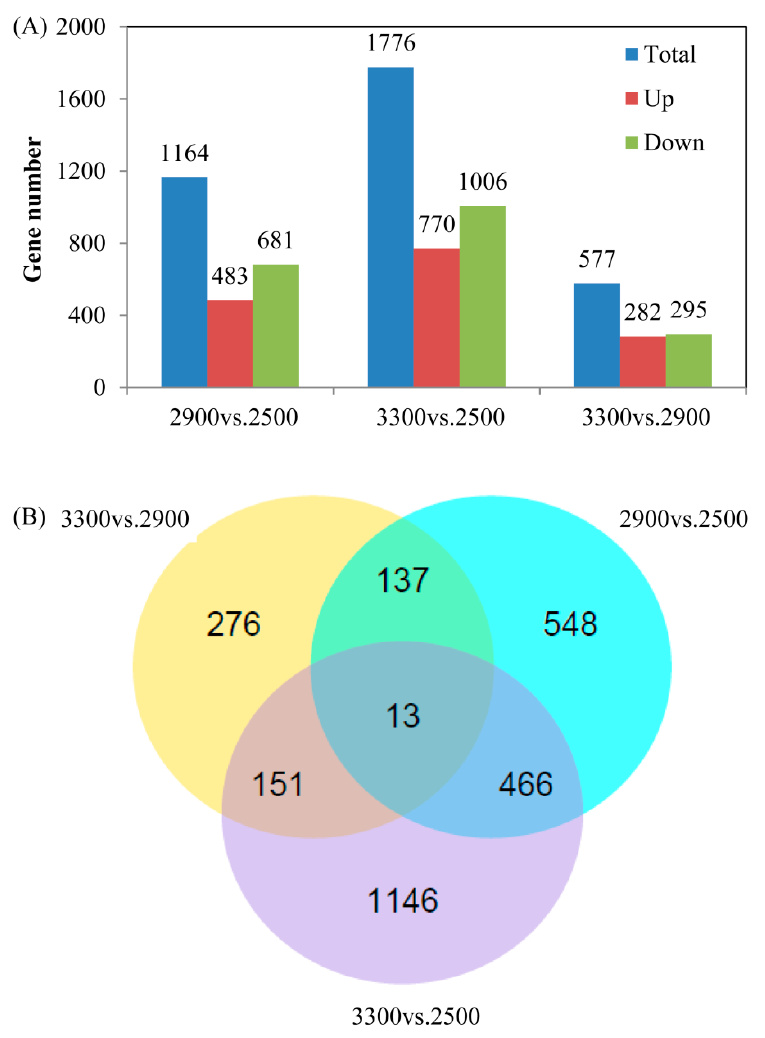
Figure 4. Transcriptomes of Picea crassifolia with elevations. ( A ) Numbers of differentially expressed genes (DEGs). ( B ) Venn diagrams showing unique and shared DEGs between altitudes.